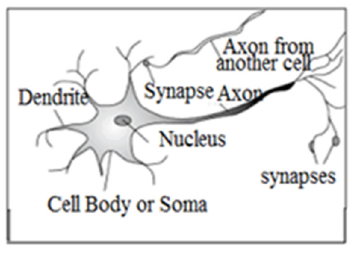
Figure 1: Representation of the basic structure of a real neuron.